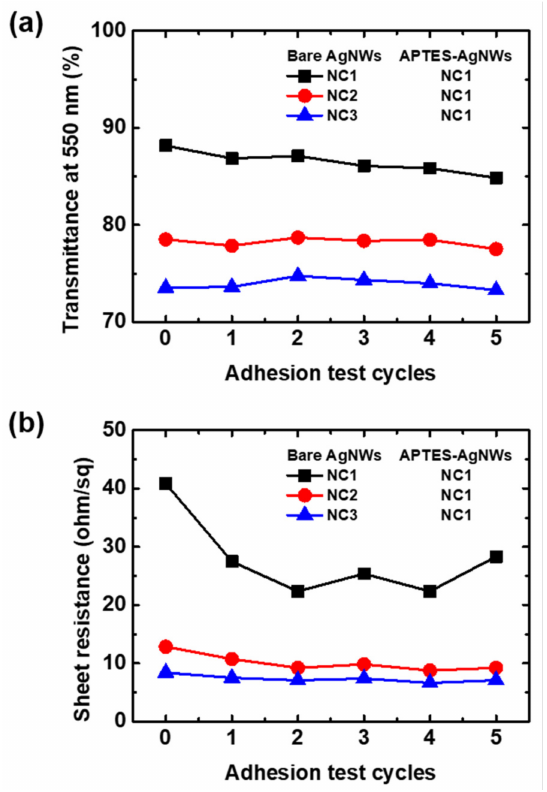
Figure 6. ( a ) Transmittance at λ = 550 nm and ( b ) sheet resistance of the APTES-AgNWs/AgNWs composite films as a function of the number of tape test cycles. The AgNW thin films were deposited on a glass substrate using 20 µ L of the 0.5 wt.% bare AgNW suspension at NC = 1–3. The APTES- AgNWs were coated on the bare AgNWs deposited using 8 µ L of the 0.32 wt.% APTES-AgNW suspension at NC =